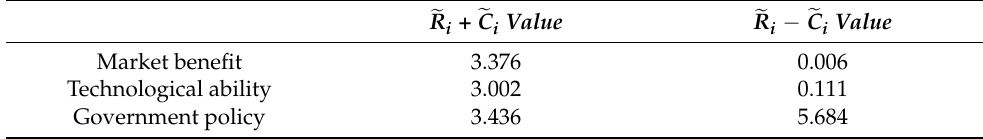
def def value and ( (cid:101) R i − (cid:101) C i ) value of the impacts of the three